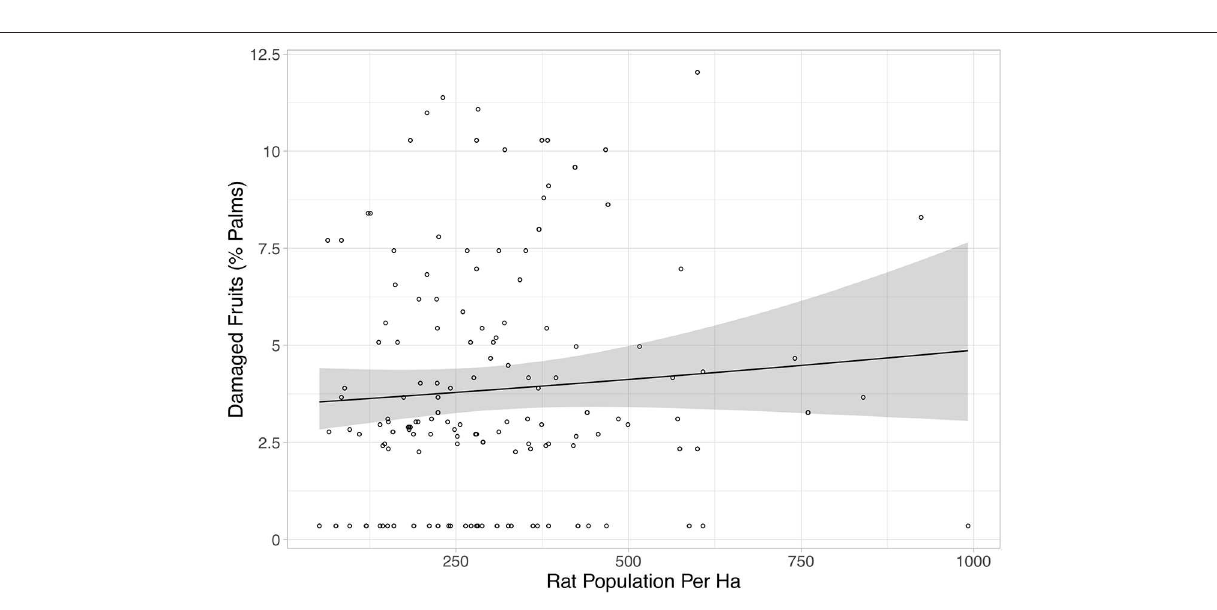
FIGURE 5 | The percentage of damaged fruits against rat population per ha. Each individual point represents a single plot, and all treatments and time points are included. The black line is the line of best fit (Equation 5 in Supplementary Information , Equation 5 in Table 1 ), and the shaded area shows 95% confidence intervals. This relationship was not